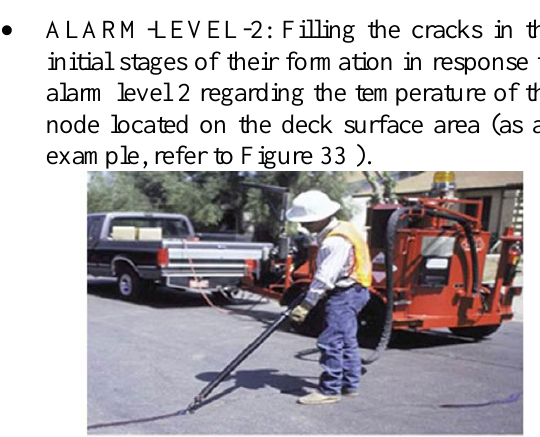
Figure 32. Pressure washing the drainage system [5].